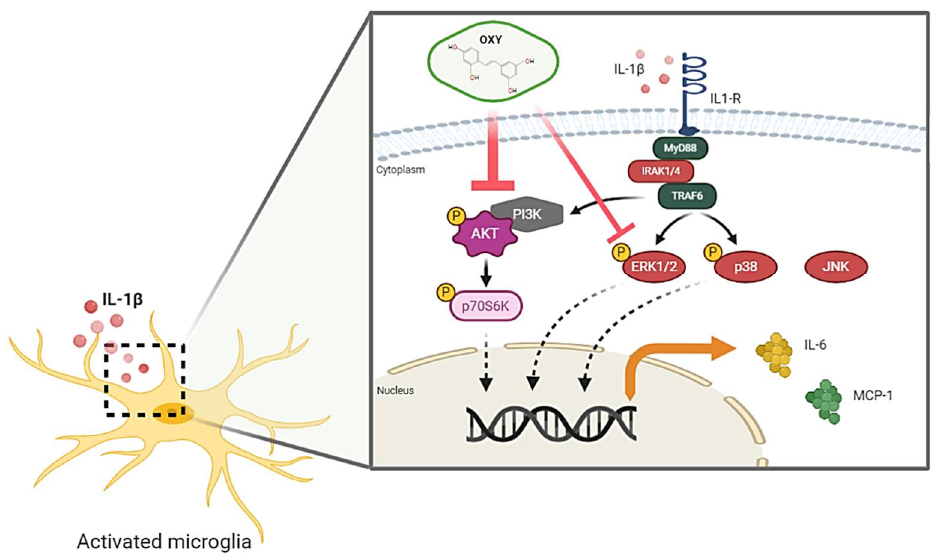
Figure 10. Schematic picture proposing that OXY modulates the IL-1β-stimulated inflammatory response. OXY drastically suppresses the activation PI3K/AKT/p70S6K signal transduction pathway, but mildly inhibits the ERK1/2 MAPK signaling, resulting in the downregulation of pro-inflammatory cytokine and chemokine production in response to IL-1β induction.